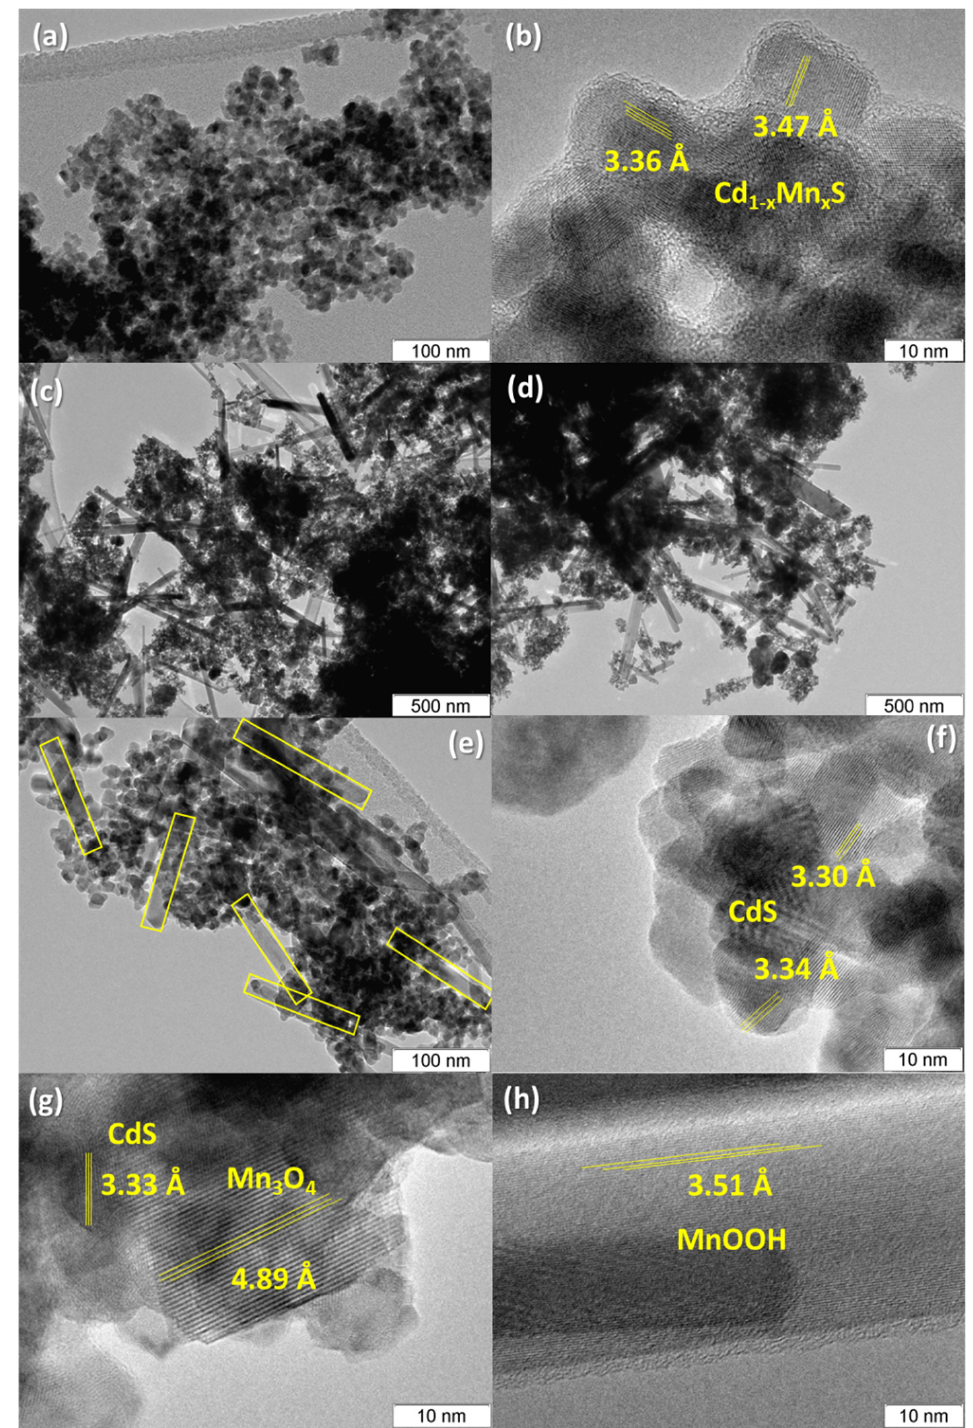
Figure 4 . Transmission electron microscopy (TEM) images of Mn0.4 ( a , b ) and Mn0.6(NaOH) ( c–h ) samples.